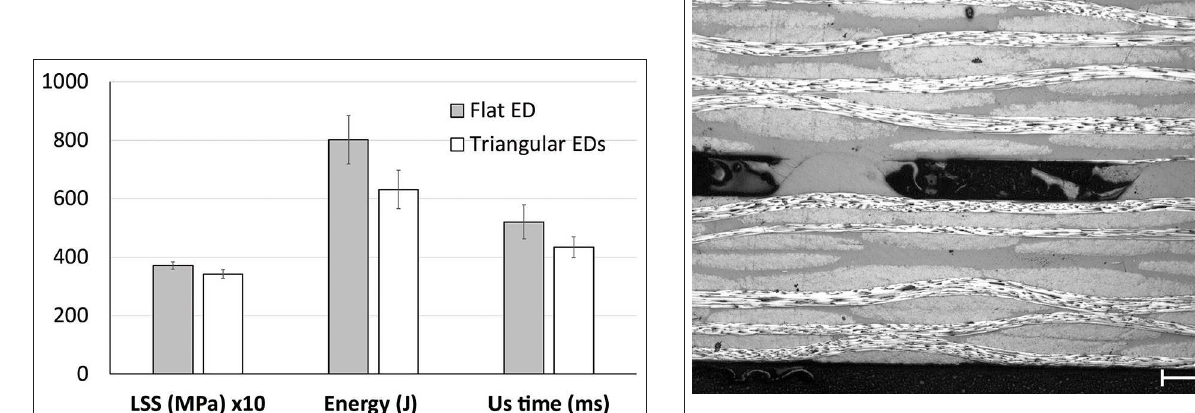
Frontiers in Materials |